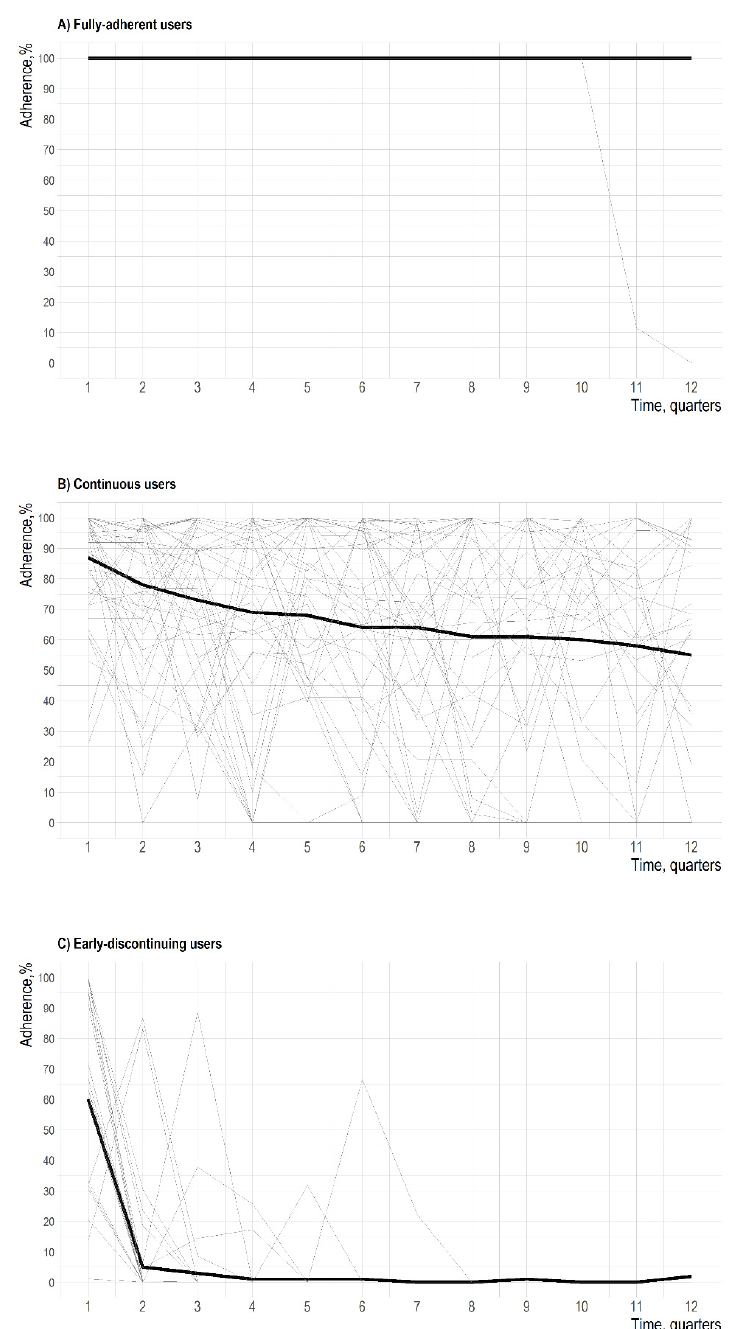
Figure 3. Spaghetti plots of random samples of 50 patients selected from each of the three adherence trajectories. Individual and mean trajectories are displayed in grey and black, respectively.